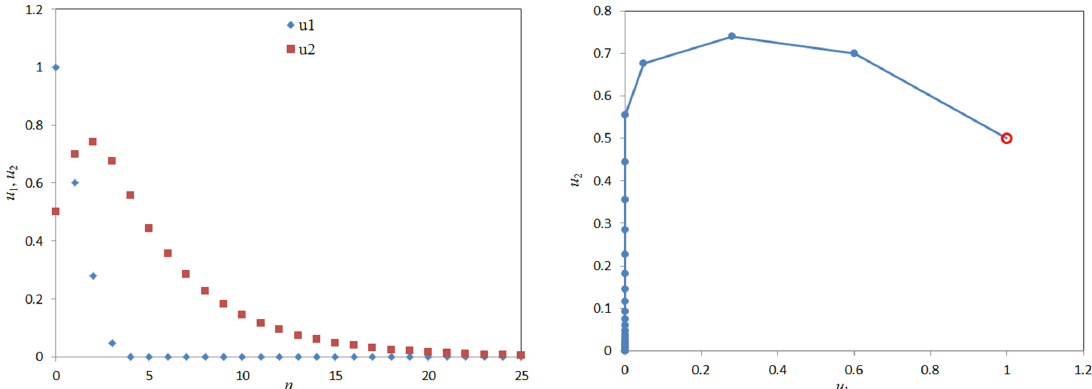
Figure 9. Dependencies u 1 ( t ) and u 2 ( t ) ( left ) and the phase trajectory of the worker-employer conflict ( right ) for 𝑢 ( 0 ) = 1; u ( 0 ) = 0.5; k = − 0.3; k = 0.2; k = 0.2; and k = 0.3 ( | λ | = 0.787; θ = 19.53). The discrepancy u 1 corresponds to the worker while the discrepancy u 2 corresponds to the employer.